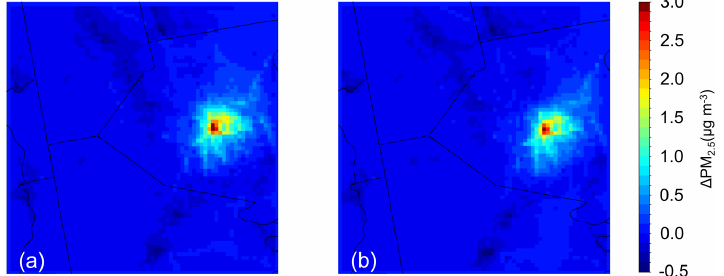
Figure 7. Difference between predicted monthly average PM 2 . 5 mass concentration when using novel surrogates and original surrogates in (a) February 2017 and (b) July 2017 for the 1km × 1km resolution simulation grid. A positive value indicates a higher concentration predicted with the novel surrogates. Table 4. Performance of daily average predicted total PM 2 . 5 concentrations compared to daily measurements from regulatory sites and low- cost sensors with the use of old surrogates and new surrogates for on-road traffic and commercial cooking within the 1km × 1km resolution